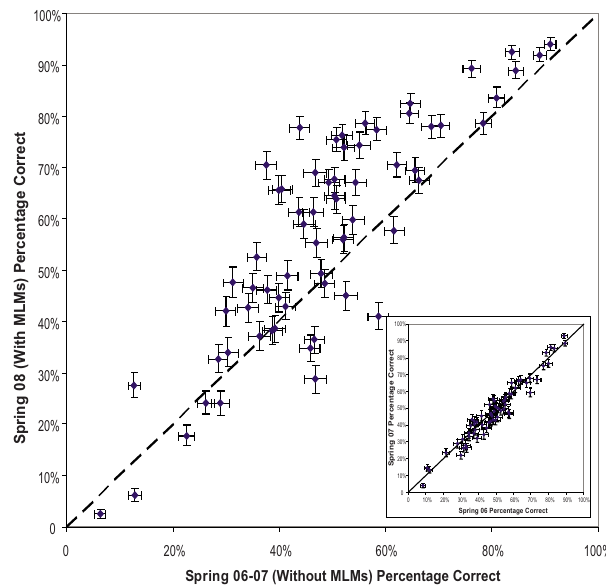
FIG. 1. (cid:1) Color (cid:2) Scatter plot of students’ performance on 64 se- lected preflight questions. Each point represents one preflight ques- tion. The x coordinate of a dot represents the average percentage of correct answers for that problem among all the students in Spring 06 and Spring 07 semesters (cid:1) without prelecture intervention (cid:2) . The y coordinate is the average percentage of correct answer for the same problem from students in Spring 08 semester (cid:1) with prelecture inter- vention (cid:2) . The error bars represent the statistical uncertainty for each question assuming a binomial distribution. For the same set of pre- flight questions, we plot in the inset performance data from students in Spring 06 semester vs. students in Spring 07 semester. Here, all points clustered around the y = x line, in sharp contrast with the asymmetric distribution in the main